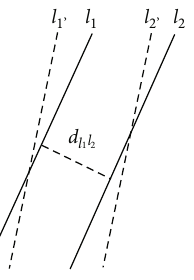
Figure 9: Plots of the 7same group of structural surface space distance by